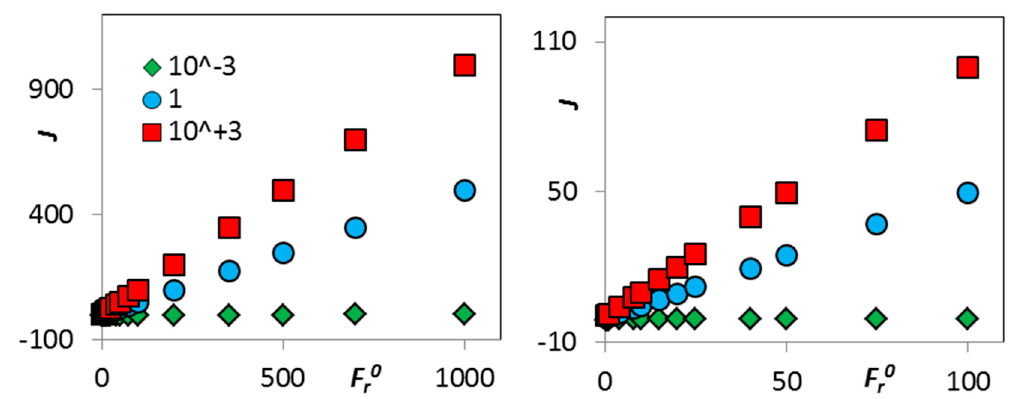
Figure 2. Schematic examples of the dependence of the reaction rate on the kinetic forcing ( 𝐹 (cid:2928)(cid:2868) ) for various values of the thermodynamic forcing ( D ) shown in the legend; Equation (14), 𝐹 (cid:2886)(cid:2868) = 1 . Left: overall view, right: detailed view.